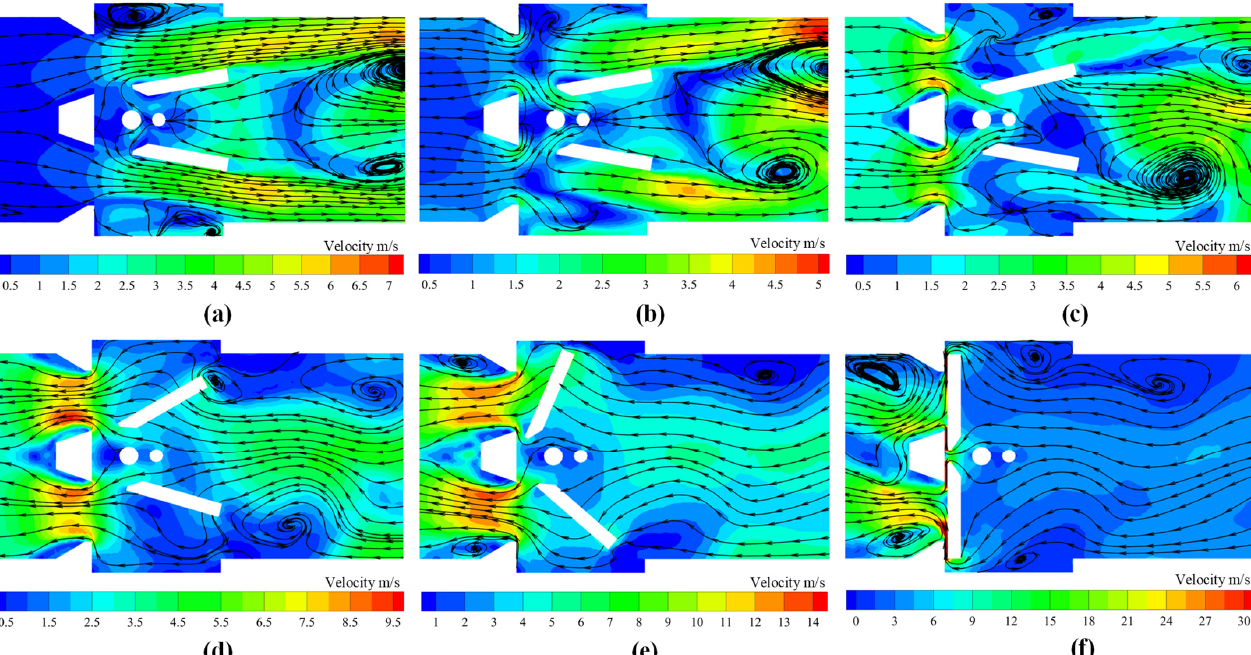
Figure 14. The instantaneous flow field diagram of the valve-closing Scheme 1. ( a ) Flow time = 1.2 s; ( b ) Flow time = 1.3 s; ( c ) Flow time = 1.4 s; ( d ) Flow time = 1.5 s; ( e ) Flow time = 1.6 s; ( f ) Flow time = 1.7 s.